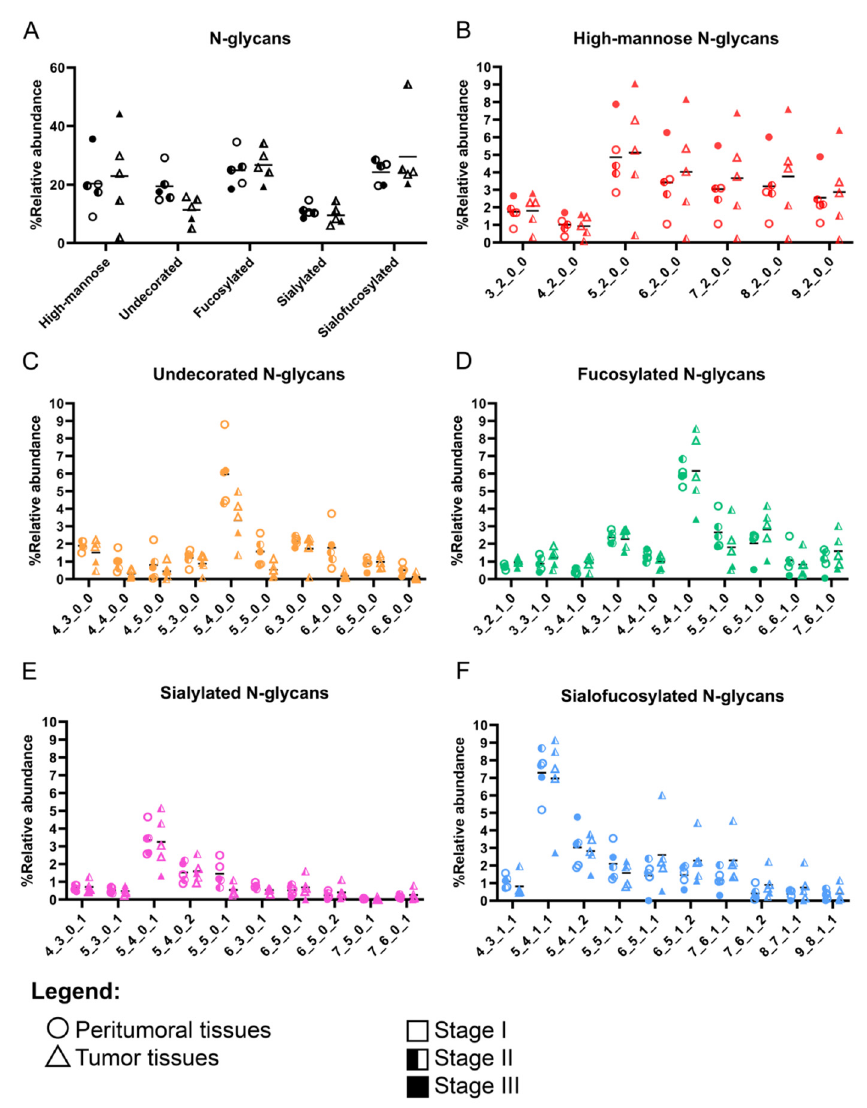
Figure 1. Cell surface N-glycome of Filipino tumor and peritumoral tissues categorized according to the lung cancer stage. ( A ) Relative abundances of high-mannose, undecorated, fucosylated, sialylated, and sialofucosylated N-glycans. Comparison of the relative abundances of the top 10 most abundant N-glycan per category—high-mannose ( B ), undecorated ( C ), fucosylated ( D ), sialylated ( E ), and sialofucosylated ( F ). N ‐ glycan composition ( x ‐ axis) is provided in the format of hexose_N ‐